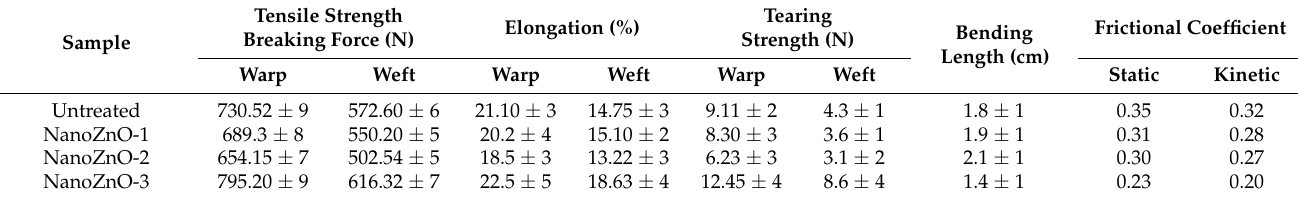
Table 3. Different mechanical properties of untreated and nano ZnO-treated cotton fabric with mean deviation.